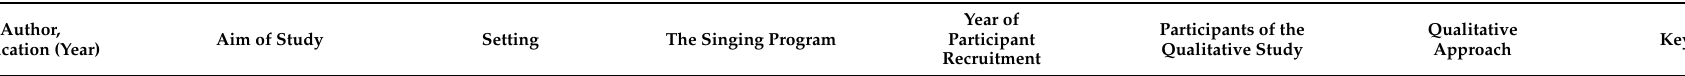
Table 2. Characteristics of included